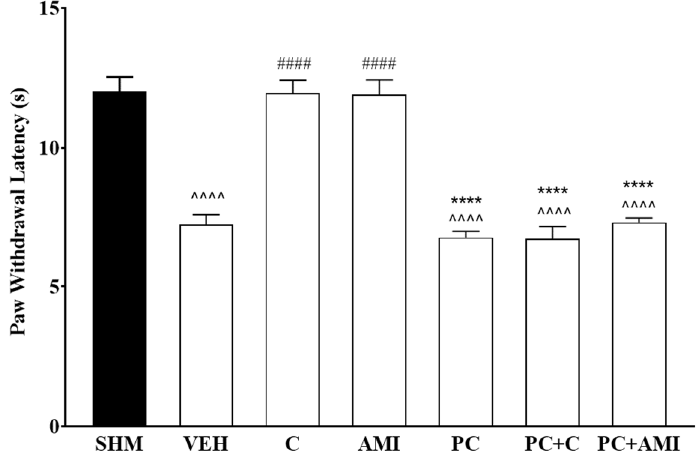
Figure 1. Effect of ρ -chlorophenylalanine (PCPA, a serotonin synthesis inhibitor) pre-treatment on cardamonin against thermal hyperalgesia in CCI-induced neuropathic pain mice, evaluated using Hargreaves’ Plantar test. Data were presented as mean ± SEM ( n = 6). The caret, hash, and asterisks denote the significance levels (one-way ANOVA, followed by Tukey’s post hoc test, ^^^^ p < 0.0001 as compared to sham, #### p < 0.0001 as compared to vehicle and **** p < 0.0001 as compared to cardamonin-treated group. SHM (Sham); VEH (Vehicle, 10 mL/kg i.p.); C (Cardamonin, 10 mg/kg i.p.); AMI (Amitriptyline, 20 mg/kg i.p.); PC ( ρ - chlorophenylalanine, 100 mg/kg i.p.).